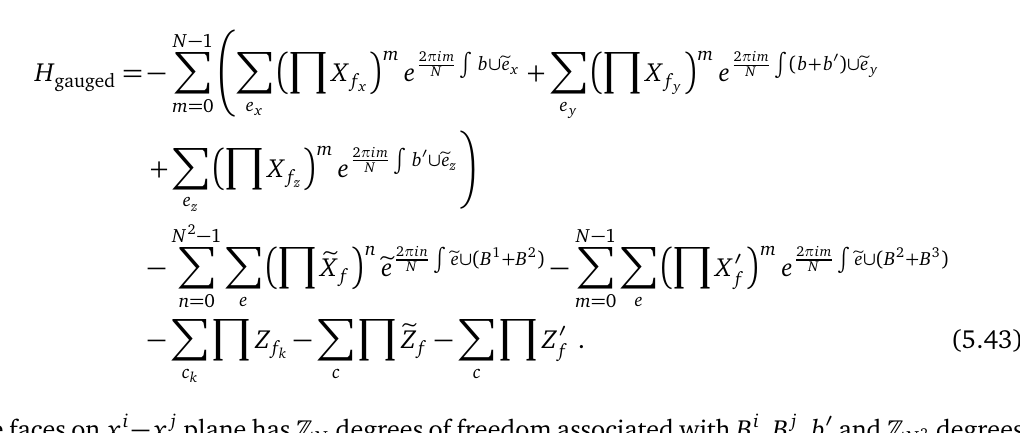
× (cid:90) Figure 7: Hamiltonian model for the (cid:90) magnetic model. The row with the (cid:90) N N 2 in the front means summing over m = 0,1, ··· N − 1 powers of such term, and similarly the row with (cid:90) in the front means summing over n = 0,1, ··· N 2 − 1 powers of such N 2 analogue of Pauli X , Z matrices, while the other terms. The variables (cid:101) X , (cid:101) Z are the (cid:90) N 2 variables are the (cid:90) analogue of Pauli matrices. N After gauging the shift symmetries, the Hamiltonian model is